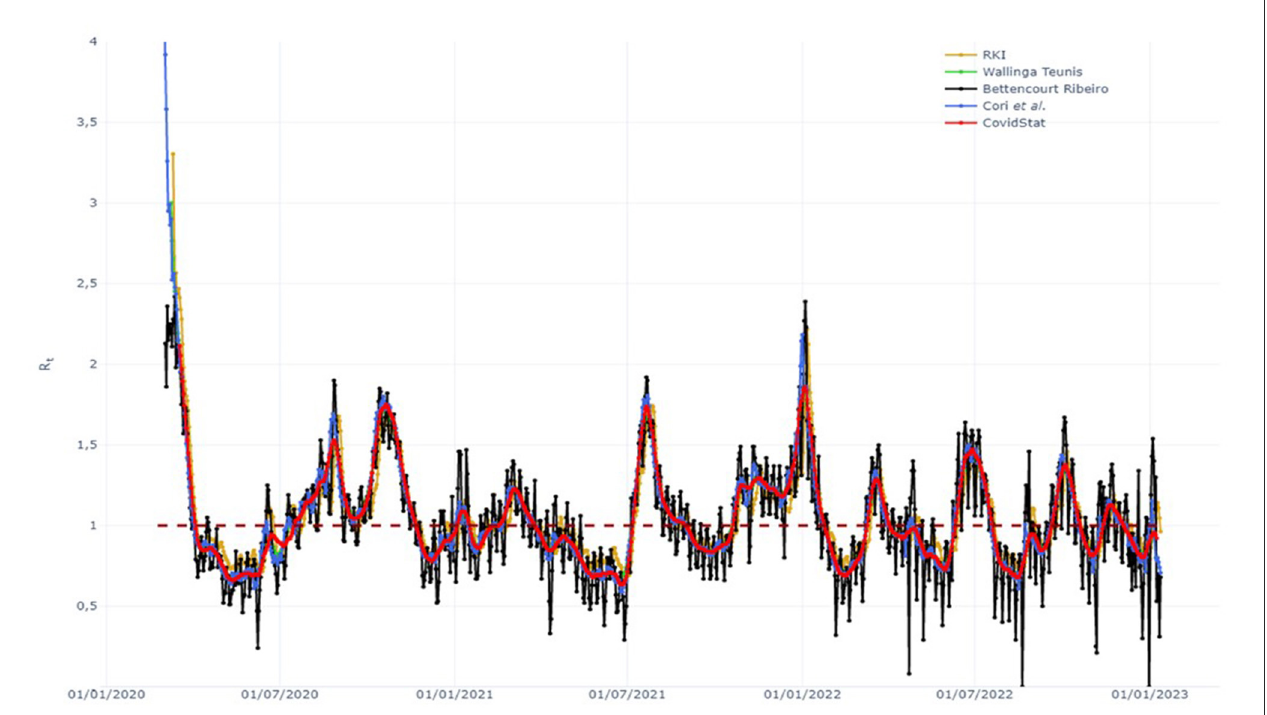
FIGURE2 Example of COVIDStat Rt trend report. National framework adapted from the website: https://covid19.infn.it/sommario/rt.html.